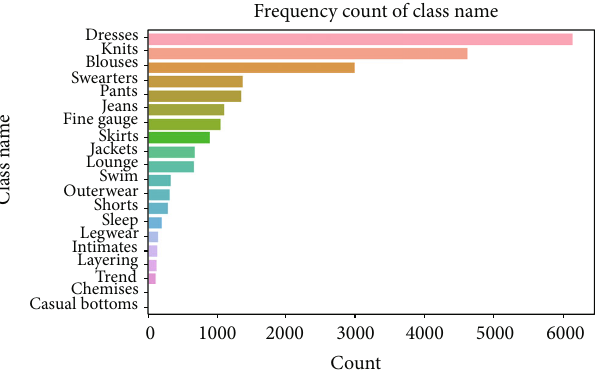
Figure 4: The distribution of the frequency of the most tested classes of clothing.